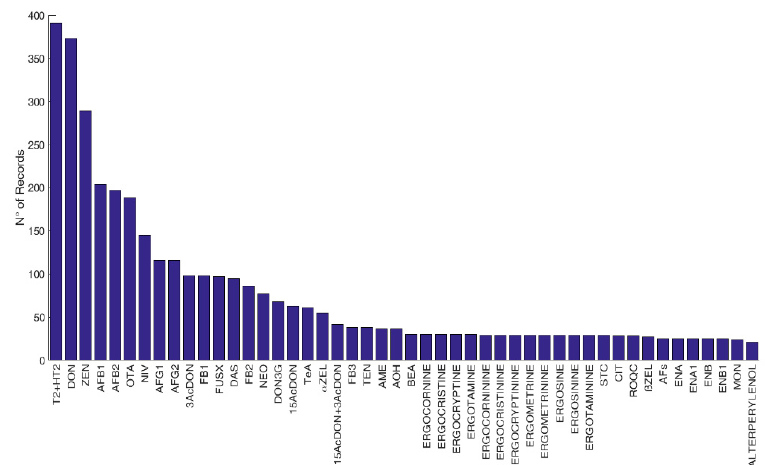
Figure 3. Frequency of reported mycotoxins and secondary metabolites in food in Europe. The figure displays the compounds with a number of records above twenty. N > 20: T2: T-2 toxin, HT2: HT-2